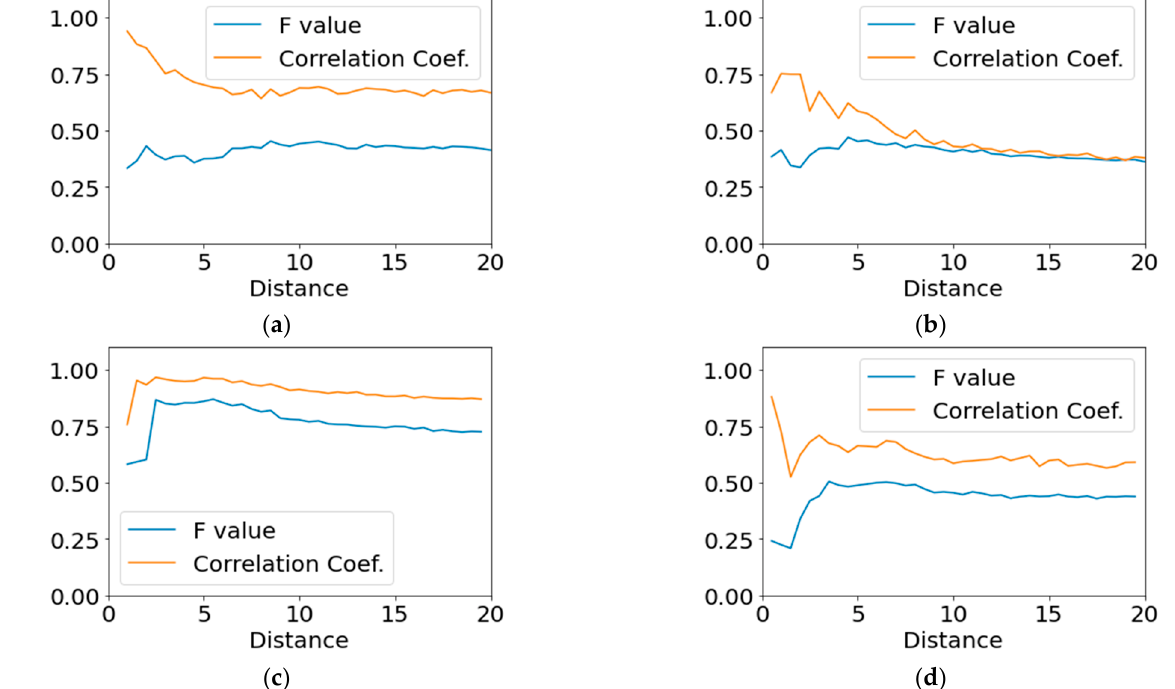
Figure 19. F-score and correlation coefficient as a function of distance for the different sites. ( a ) Site 1. ( b ) Site 2. ( c ) Site 3. ( d ) Site 4.